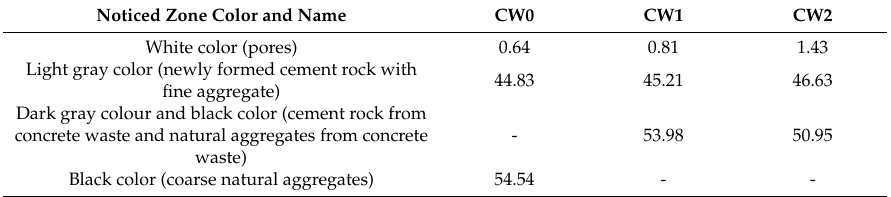
Table 4. Areas of complex phases noticed in the cross-section of concrete samples, %.